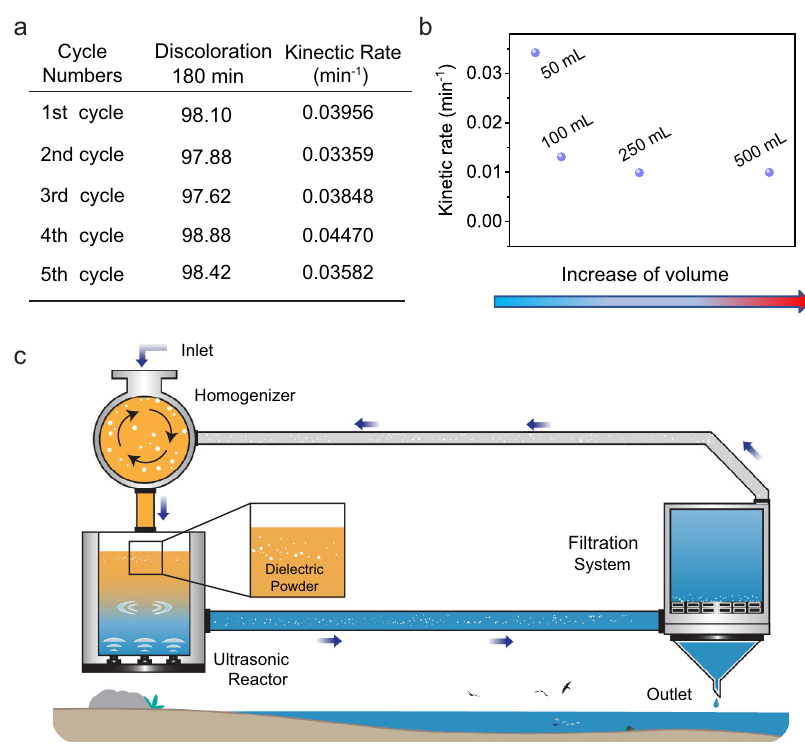
Fig. 5 Recyclability of contact-electro-catalysts. a Evolution of degradation from one to fi ve cycles of reaction. b Investigations on the degradation rate for different volume MO solutions. c Expected large application of contact-electro-catalysis for the treatment of organic